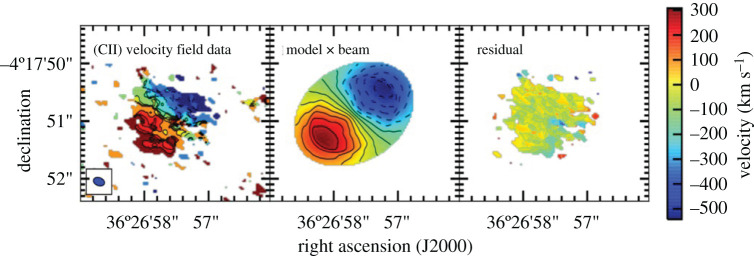
The brightness of the [CII] line has allowed it to be imaged and spatially resolved particularly quickly in high-redshift galaxies with ALMA, facilitating dynamical modelling. Here the [CII] line is resolved at approximately 1 kpc resolution in a z ∼ 3 galaxy and compared with a model of a rotating disc. Figure from Leung et al. [474].